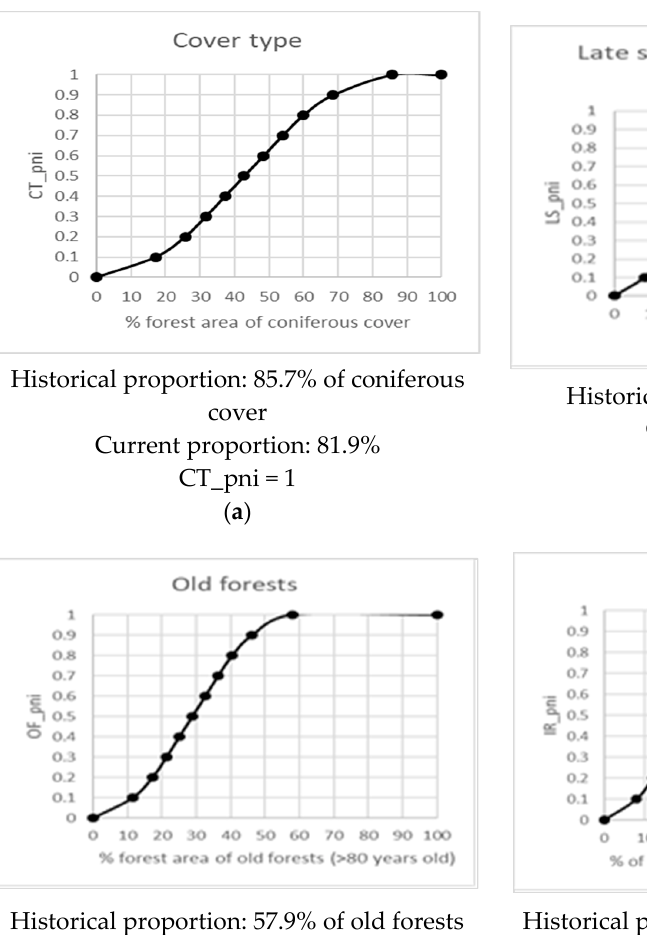
Figure A2. Curves determining the potential naturalness index to evaluate the condition indicators (condition_pni) for FM-A using local studies for reference data: ( a ) coniferous cover type; ( b ) late successional characteristic species; ( c ) old forests; ( d ) irregular stands; ( e ) closed forests.